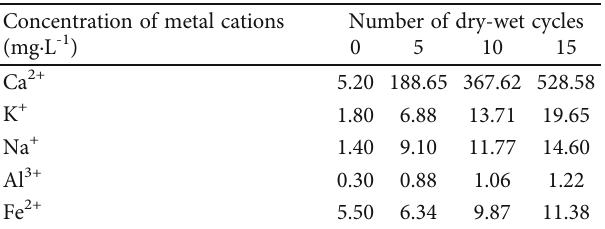
Table 2: Concentration of metal cations in aqueous solution under dry-wet